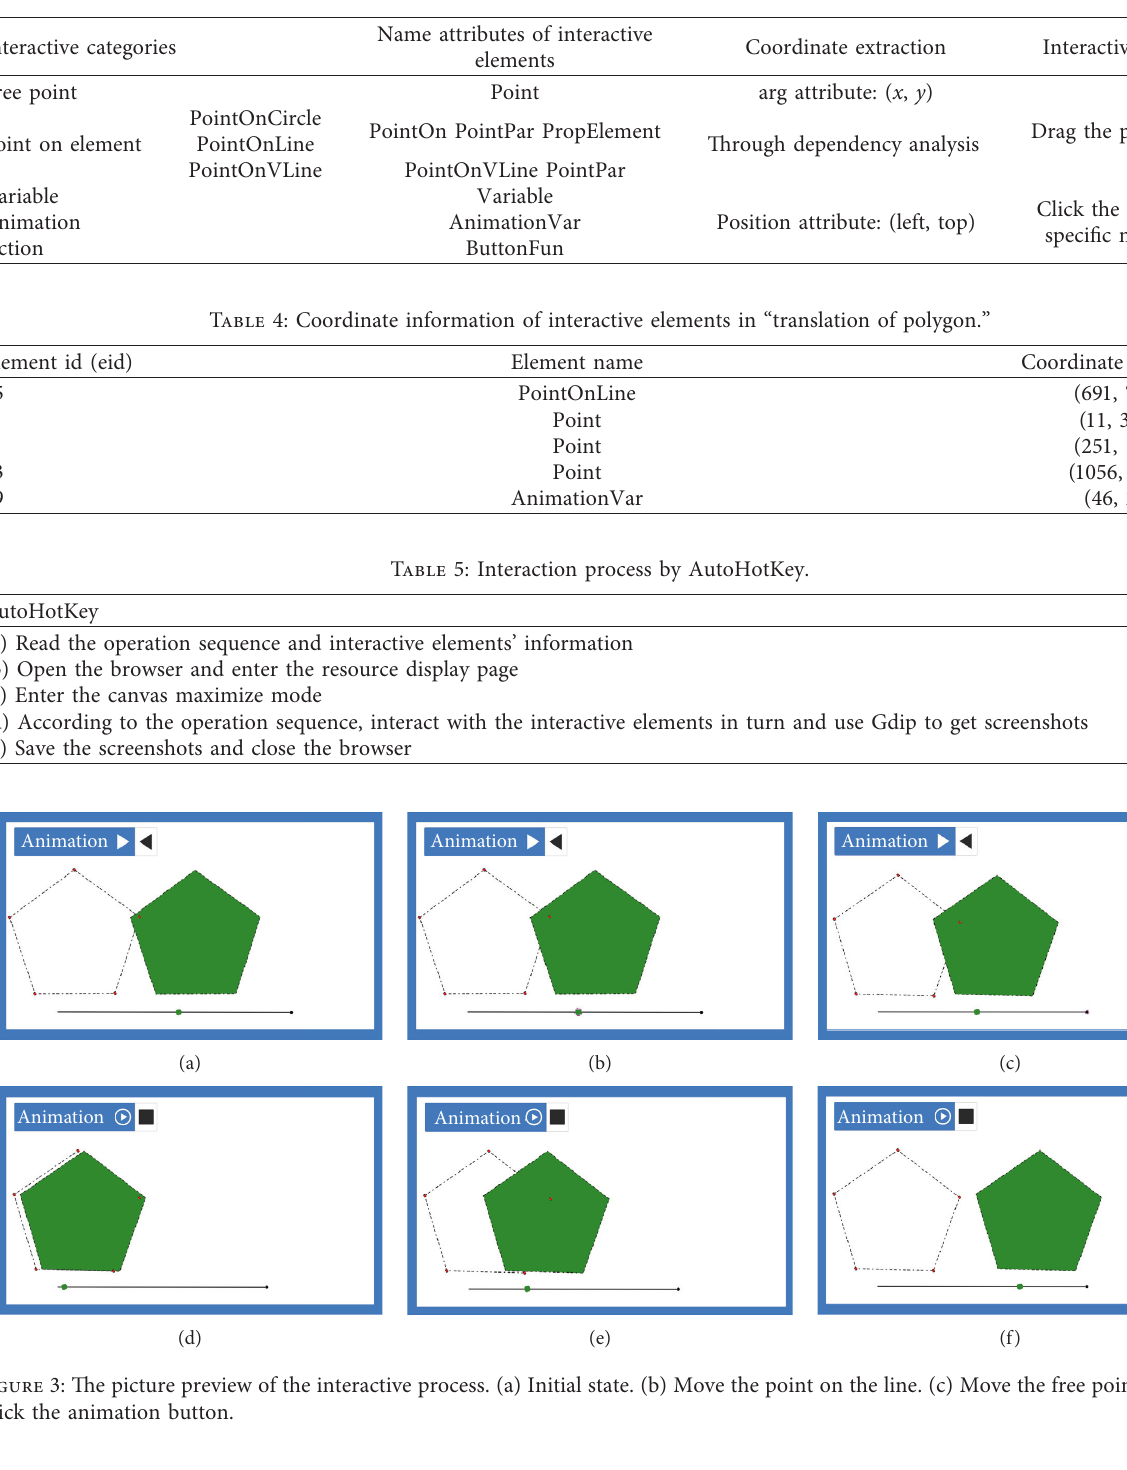
Table 3: Interactive elements’ information.